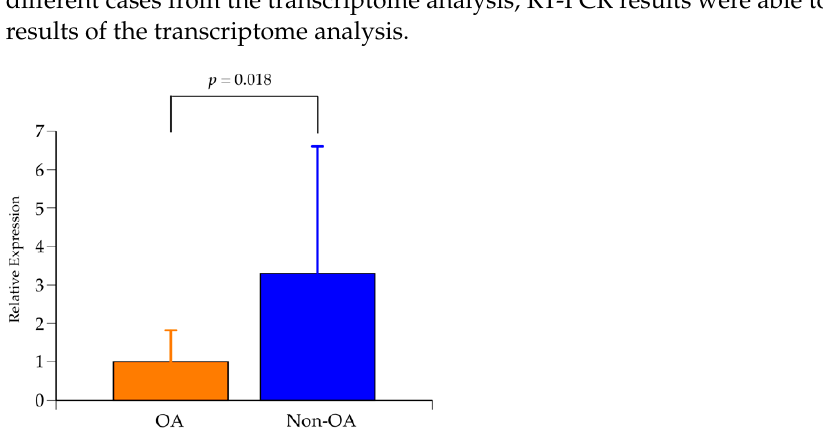
Figure 3. GCH1 expression in samples from 8 non-OA patients and 12 OA patients. OA: osteoarthri- tis.